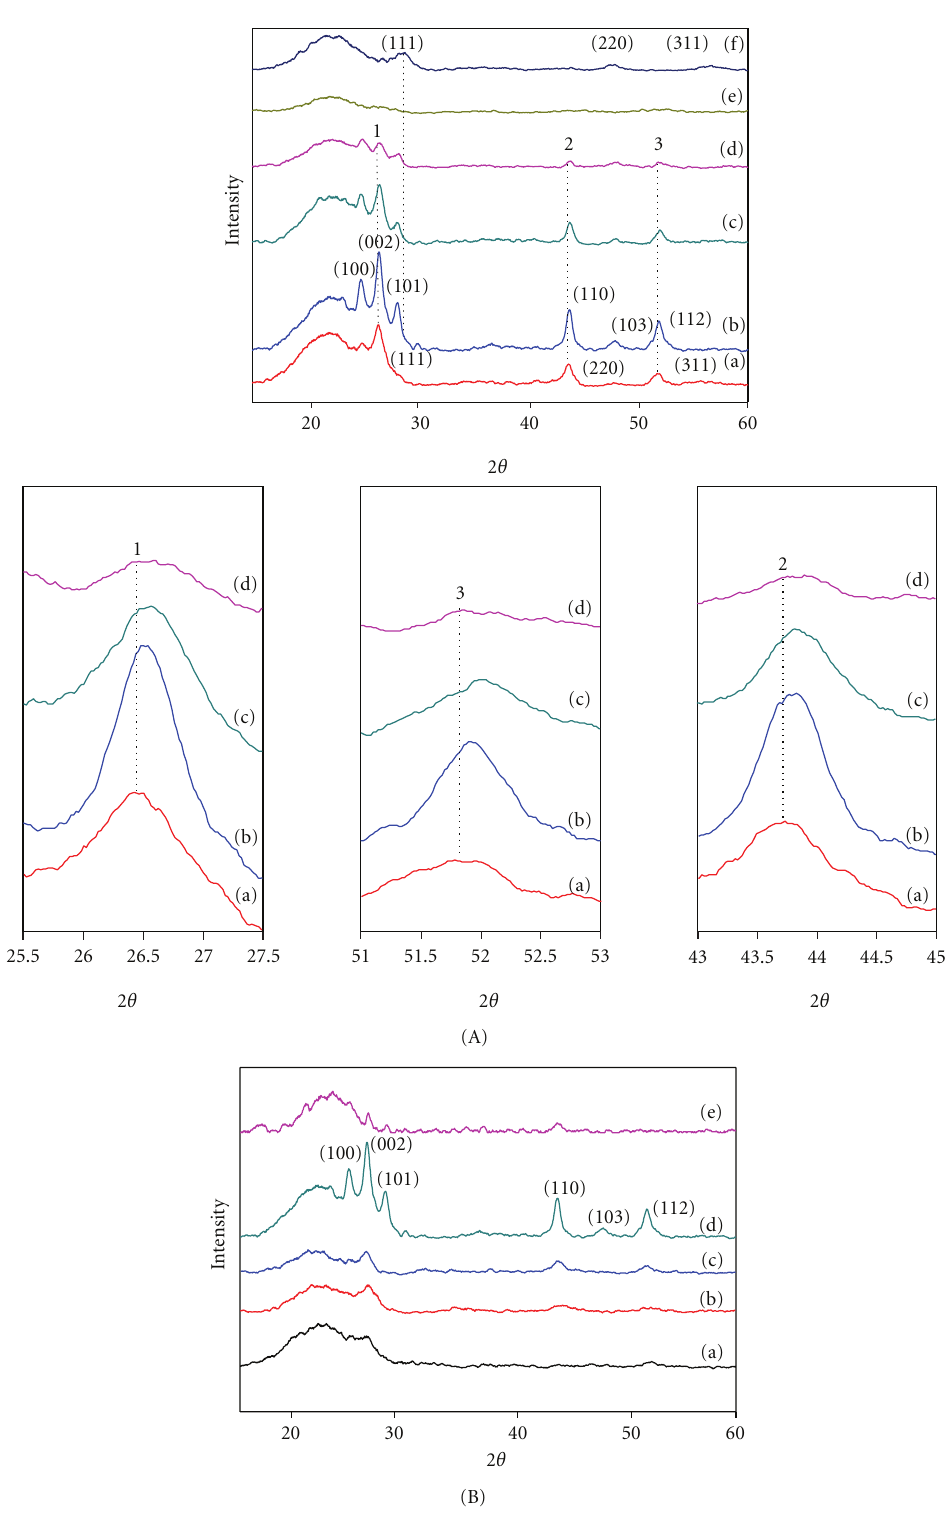
Figure 2: XRD patterns of Cd 1 − x Zn x S / SiO 2 samples with di ff erent composition (A): (a) x = 0, (b) x = 0.2, (c) x = 0.4, (d) x = 0.6, (e) x = 0.8, and (f) x = 1 and of Cd 0 . 8 Zn 0 . 2 S/SiO 2 sample calcined at di ff erent temperature (B): (a) 393K, (b)623K, (c)673K, (d)723K, and (e)773